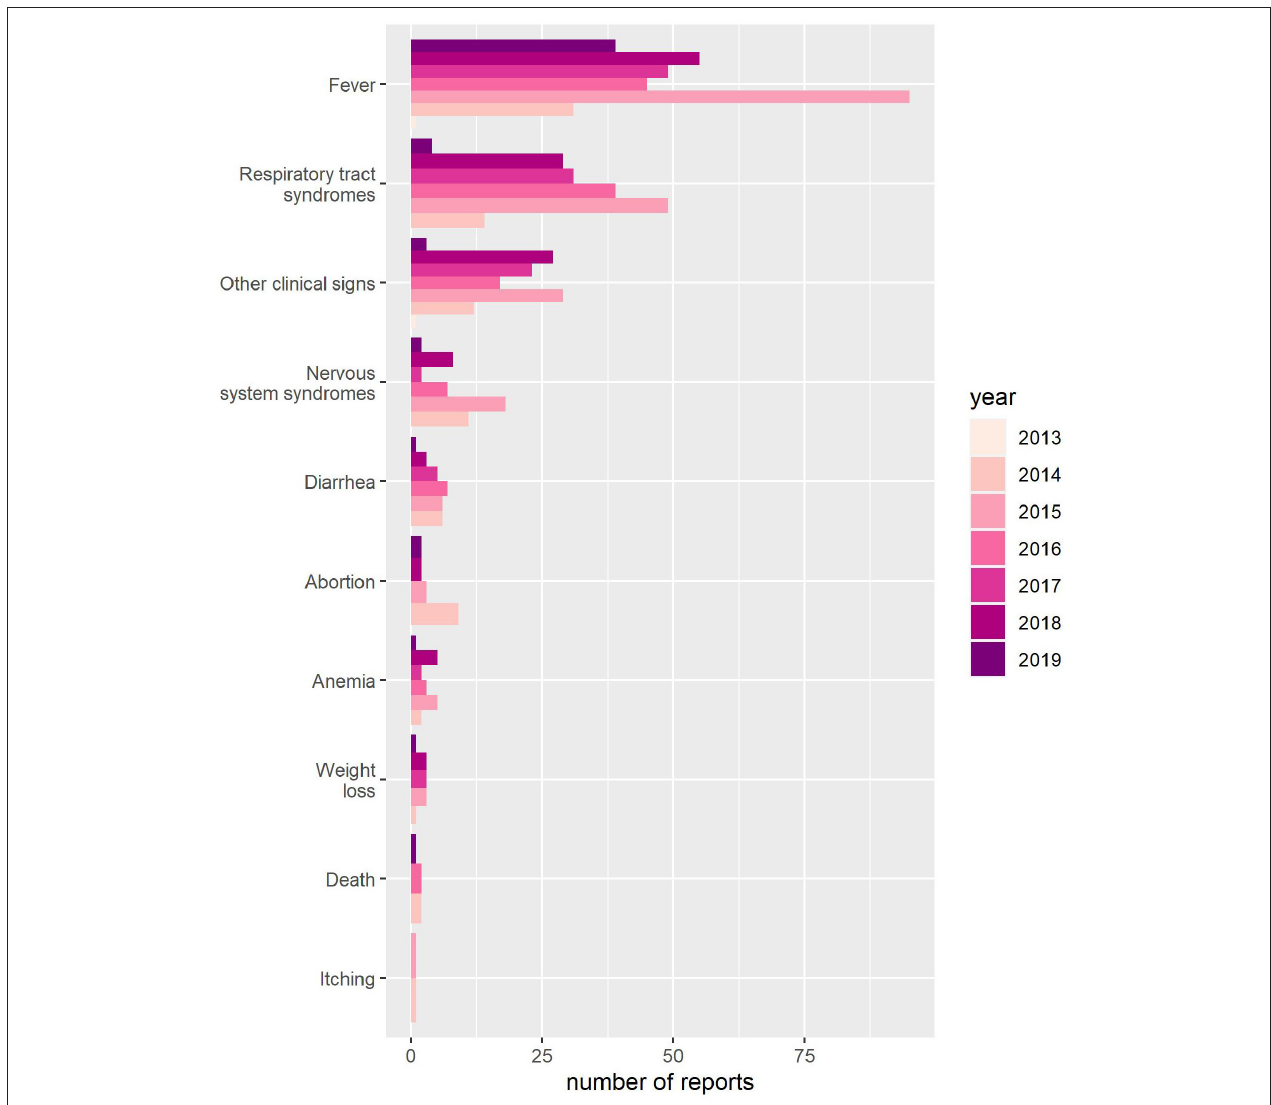
FIGURE 3 | Yearly count of clinical signs reported to Equinella between November 23, 2013, and April 26, 2019.